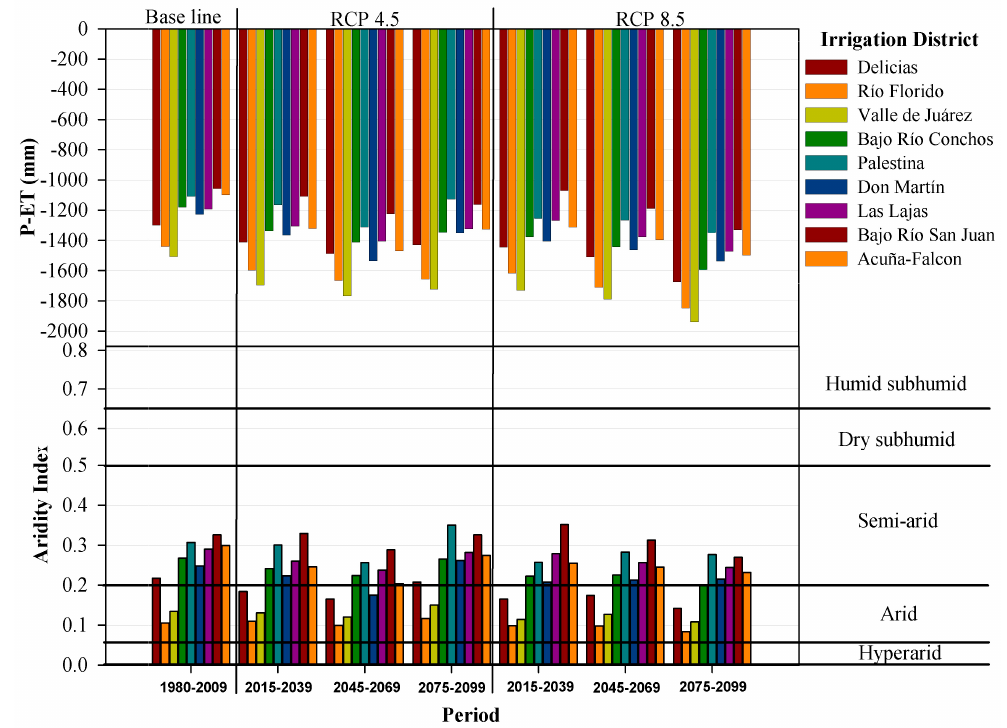
Figure 8. Changes in the aridity index ( AI ) and the difference between precipitation and evapotranspiration ( P-ET ) under the RCP4.5 and RCP8.5 climate change scenarios in the irrigation districts of the Rio Bravo Basin.